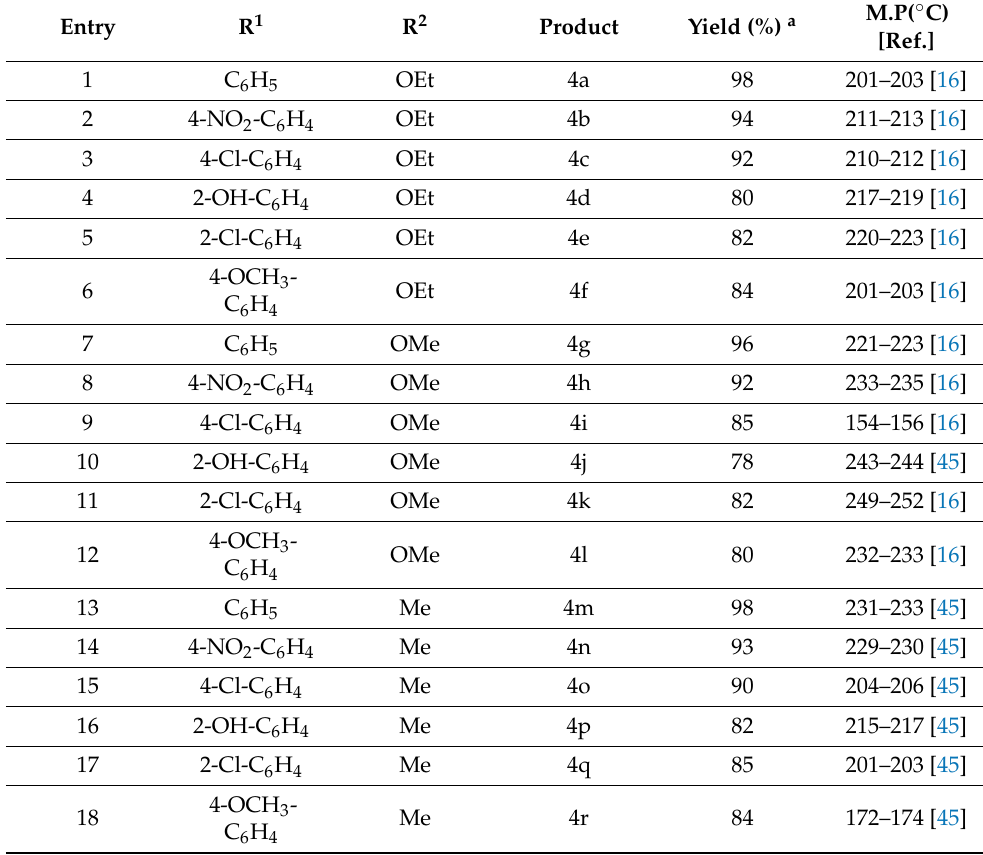
Table 2. Synthesis of dihydropyrimidones catalyzed by PMO-Py-IL nanocatalyst under solvent free conditions.